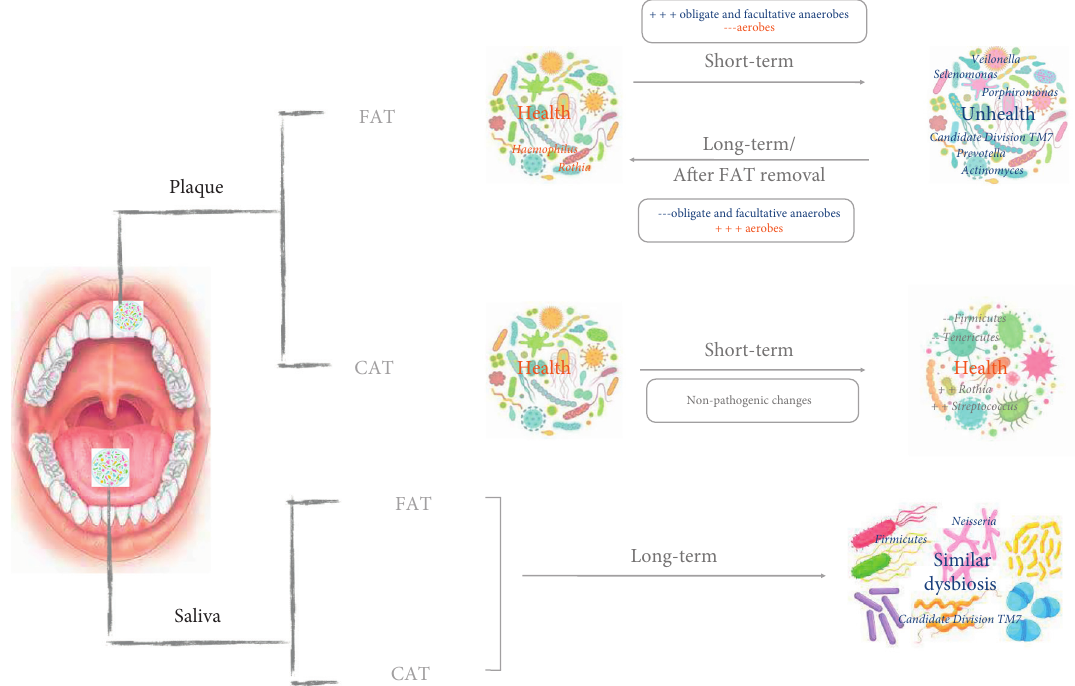
Figure 2: The effects of FAT and CAT on the microbial trends of plaque and